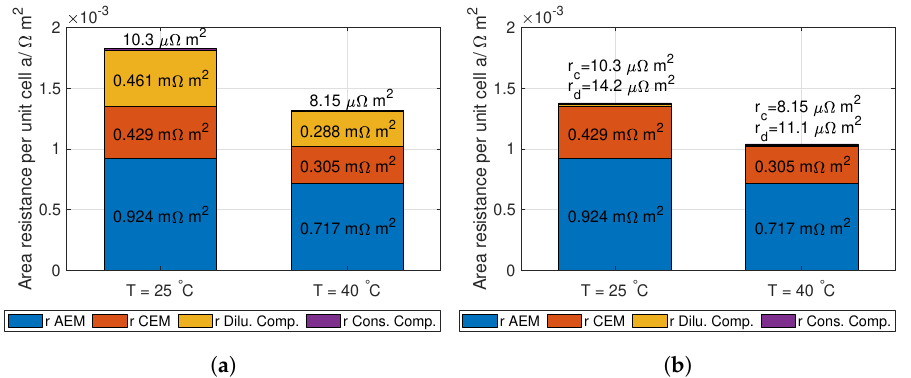
Figure 16. The total ohmic resistance in a RED unit cell at 23 ◦ C and 40 ◦ C using concentrations relevant for ( a ) evaporation and ( b ) precipitation. The calculation of the four contributions can be seen in Equation